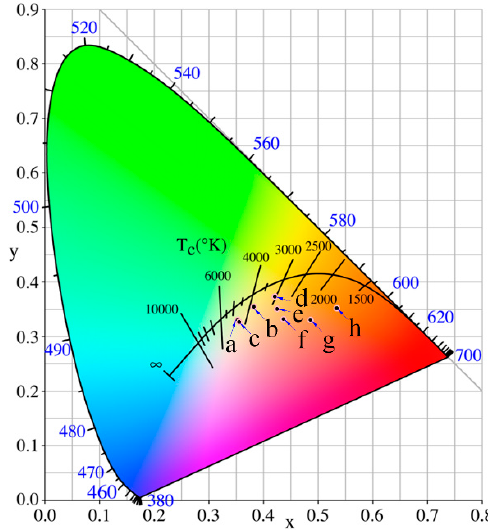
Figure 7. Chromatic CIE coordinates of iron-red hybrid pigments (a: IS-IOR, b: REC-IOR, c: KAO-IOR, d: MMT-IOR, e: VMT-IOR, f: SEP-IOR, g: HYS-IOR, and h: ILL-IOR). d: MMT-IOR, e: VMT-IOR, f: SEP-IOR, g: HYS-IOR, and h: